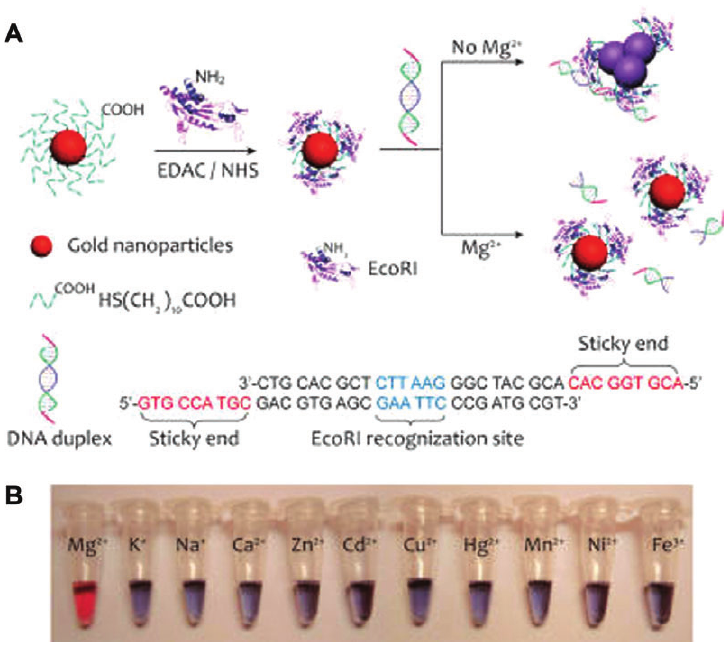
Figure 1 Eco RI-modified AuNPs for colorimetric detection of Mg 2 + . (A) Schematic design of the method. (B) Colorimetric response of the detection system in the presence of different metal ions. Adapted from Ref. [66] .